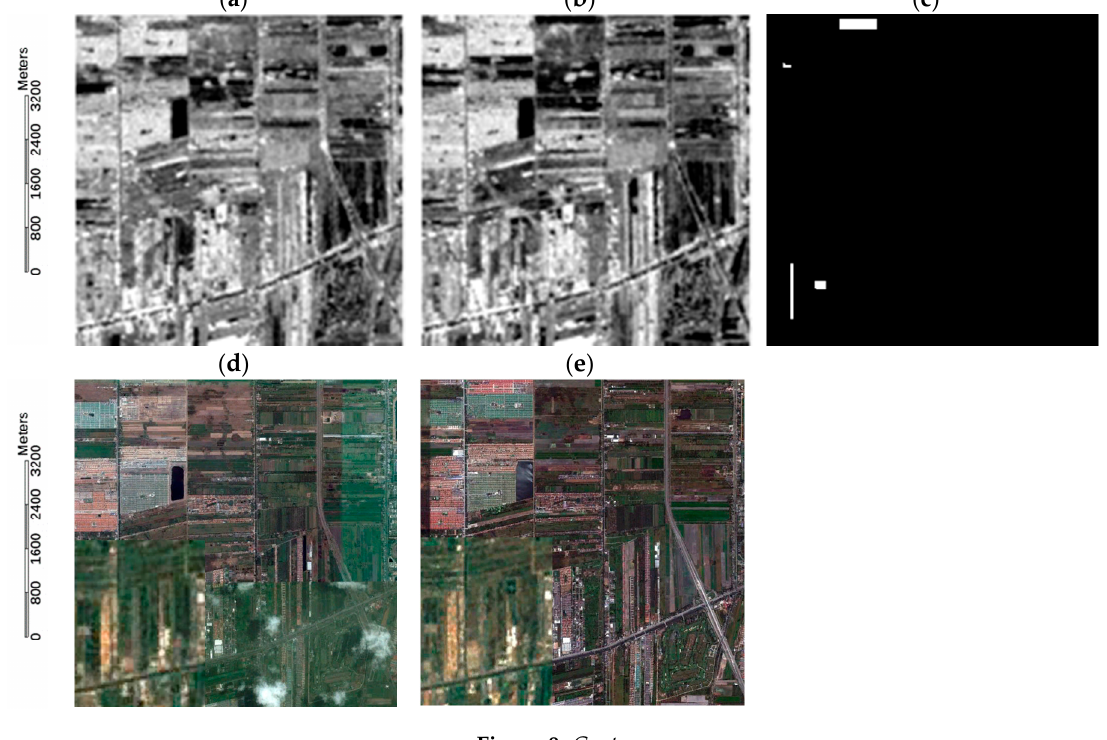
Figure 9. Results of the Bangkok site in the first area at 14°1’2.26”N 100°41’15.99”E. The size of each image is 6 × 6 km (for SAR pairs 27 November 2008/15 January 2010: ( a ) Time 1 SAR image; ( b ) Time 2 SAR image; ( c ) ground truth; ( d ) result of U-net; ( e ) proposed result).